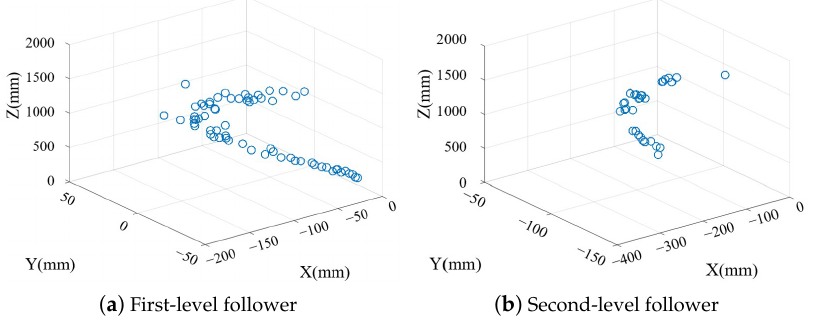
Figure 32. Three-dimensional coordinates measured by the vision of the first-level follower robot and the second-level follower robot over time.